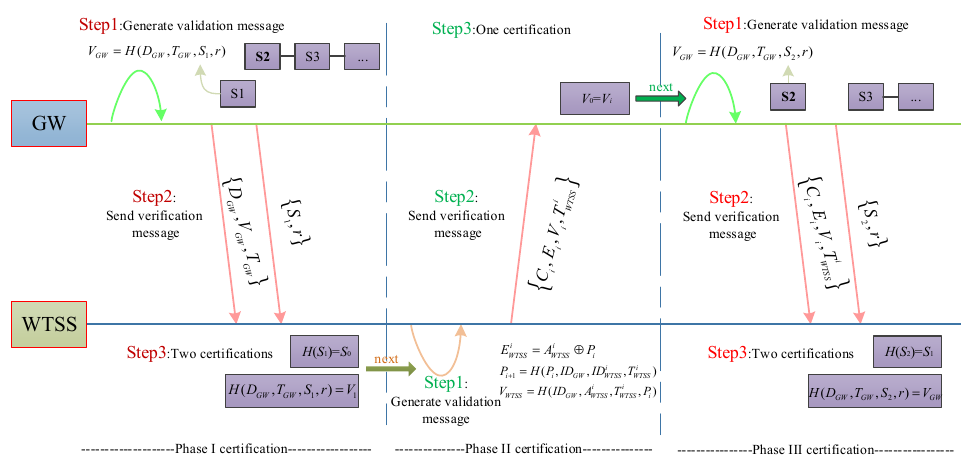
Figure 4. Execution process of agile certification model.